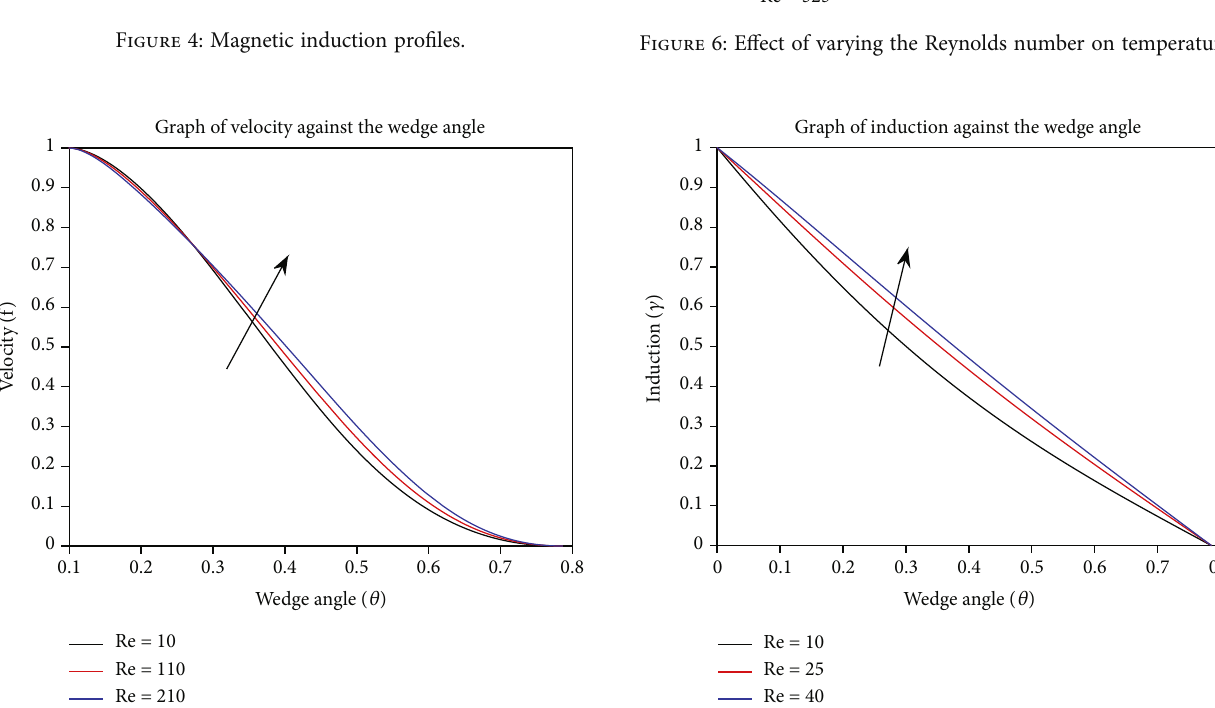
Figure 5: E ff ect of varying the Reynolds number on velocity.